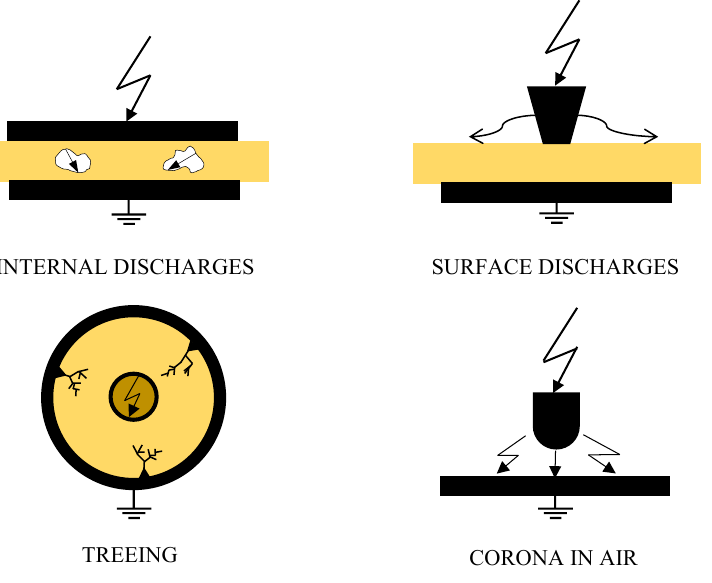
Figure 3. Different types of partial